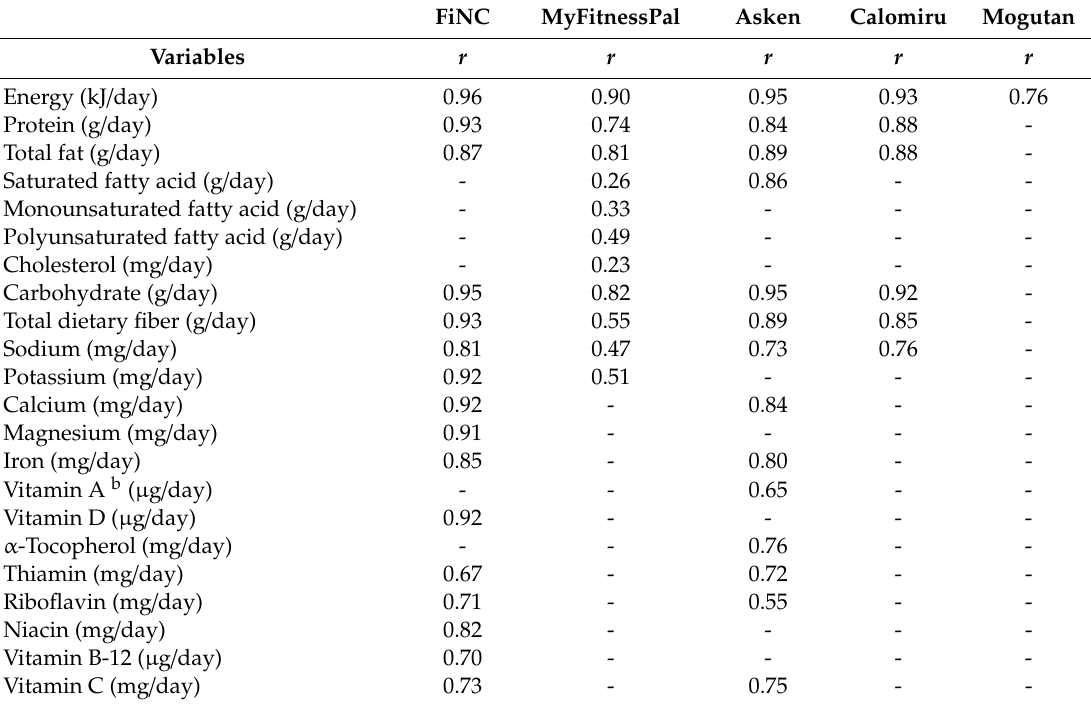
Table 3. Spearman correlation coe ffi cients for the association between energy and nutrient intakes estimated by a one-day dietary record and those estimated by the five diet-tracking applications among Japanese adults ( n = 30) a